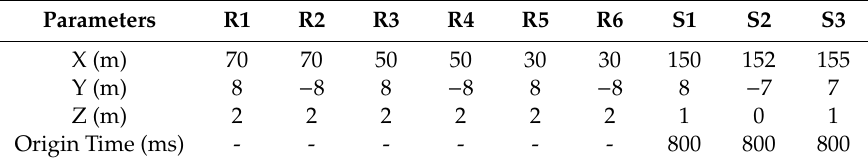
Figure 2. Monitoring model of tunnel engineering. Table 1. Receiver coordinates and theoretical source